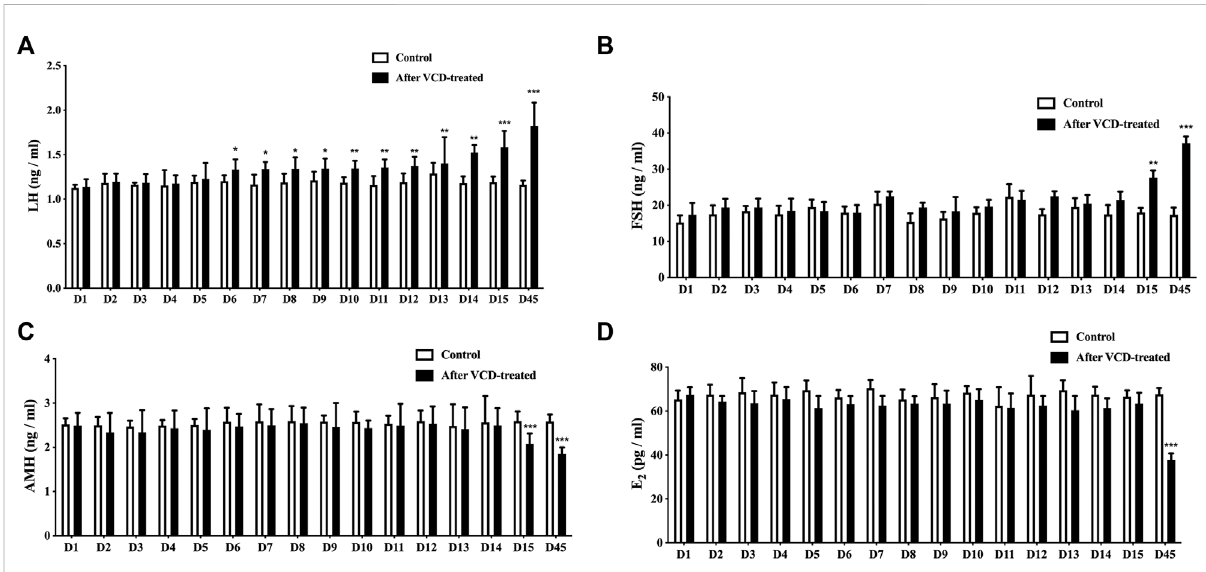
FIGURE 2 LH, FSH, AMH and E 2 serum levels. (A) LH, (B) FSH, (C) AMH, and (D) E 2 serum levelswere detected byELISA during the VCD-treated process (D1- D15, D45). Data are summarized and presented as mean ± SEM from four independent experiments. * p ＜ 0.05, ** p ＜ 0.01 and *** p ＜ 0.001 vs.